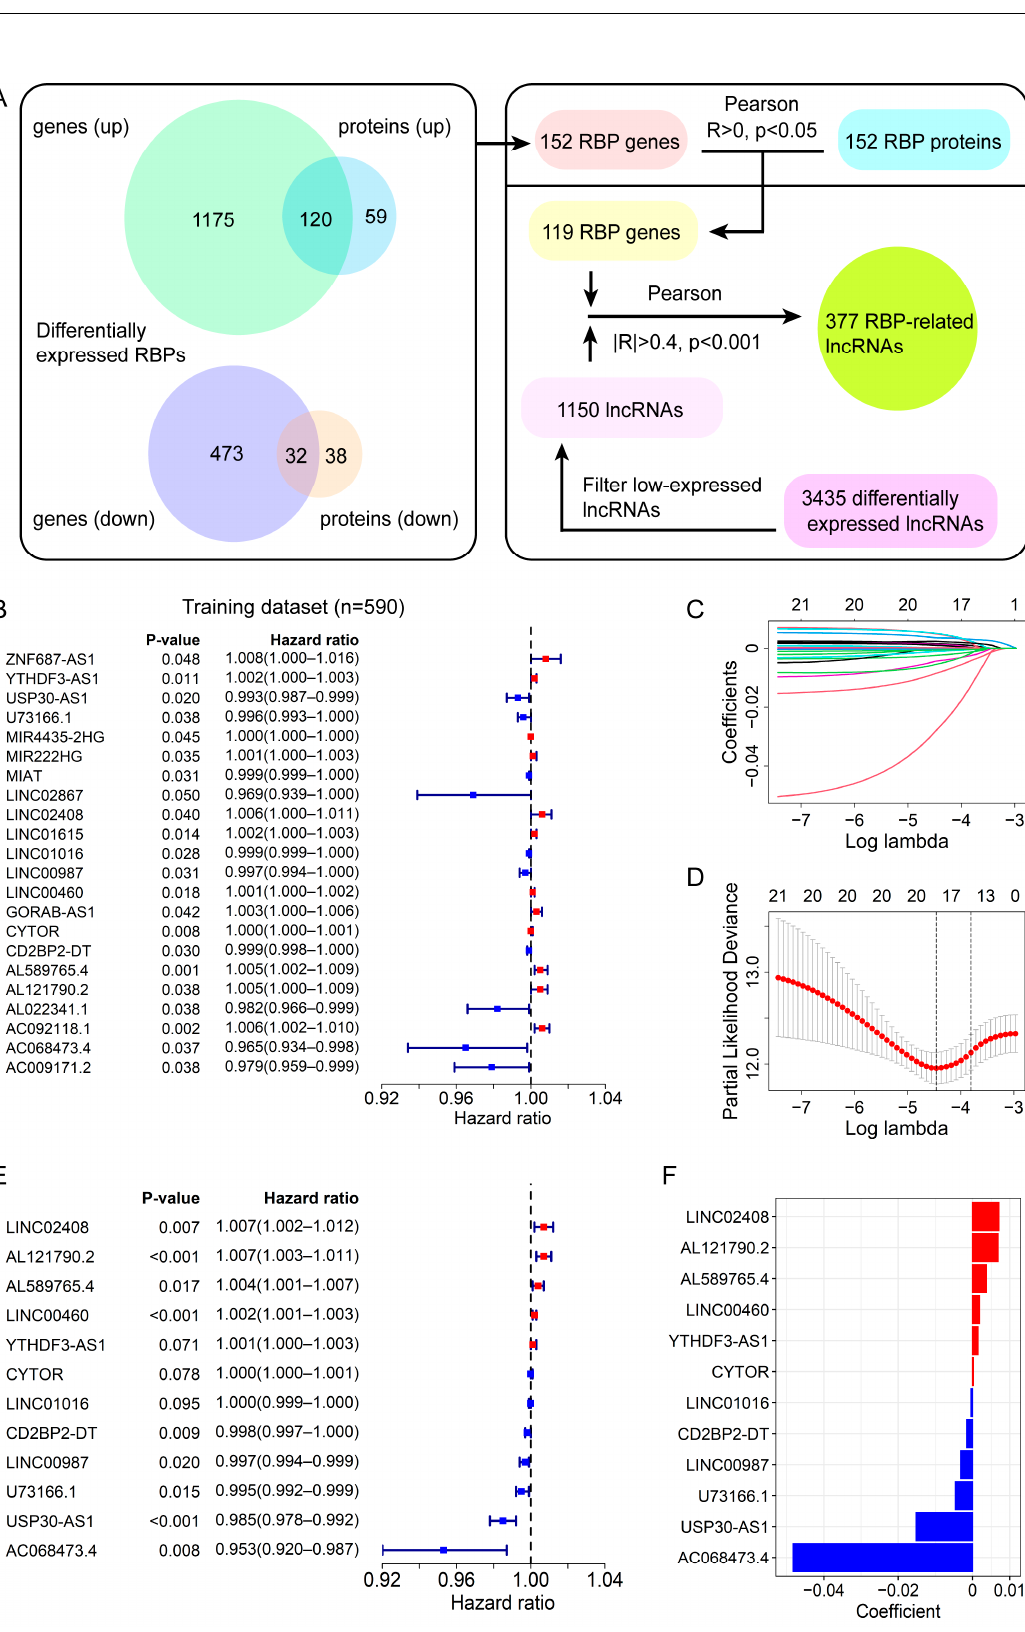
Figure 1. Identification of differential expressed lncRNAs related to RBPs and establishment of a 12-lncRNA prognostic signature. ( A ) The flowchart for identification of RBP-related lncRNAs. ( B ) Forest plot of univariate Cox regression analysis for the 22 RBP-related lncRNAs correlated with the OS of BC patients in the training dataset. ( C ) The LASSO coefficient profiles of the 22 prognosis-associated lncRNAs. The upper abscissa represents the number of lncRNAs with non-zero coefficients under the corresponding lambda. ( D ) The cross-validation graph shows the